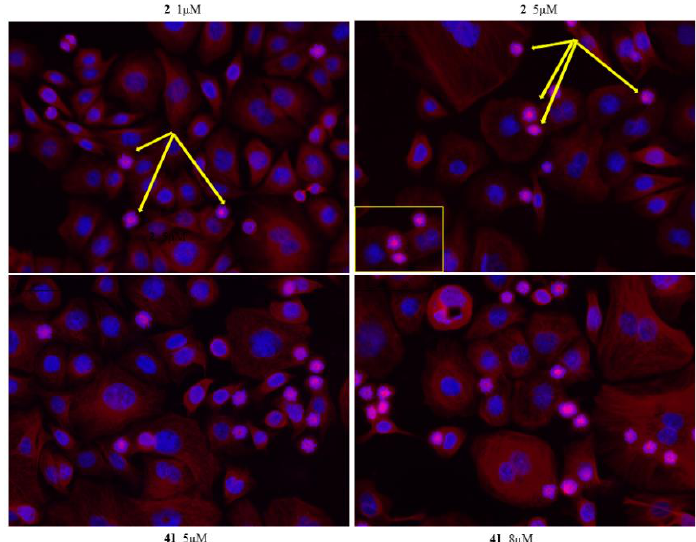
Figure 5. β-tubulin immunofluorescence analysis in AGS cell line treated with compounds 2 and 41 for 24 h. AGS cells were treated for 24 h with 2 and 5 μM of compound 2 and with 5 and 8 μM of 41 . Tubulin cytoskeleton was visualized following fixation by immunostaining, DNA was stained with DAPI. After 24 h of compounds 2 and 41 treatment, the majority of AGS cells arrested in mitosis resulting in formation of monopolar spindle (yellow